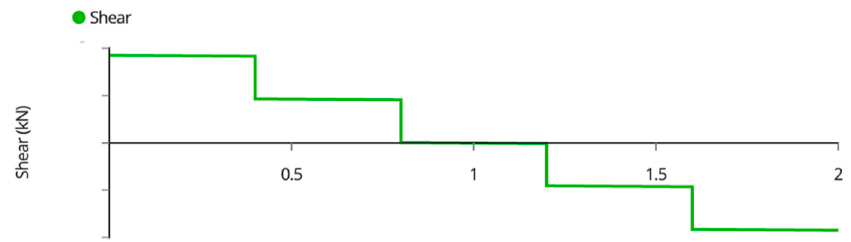
Figure A2. Joist shear force diagram.